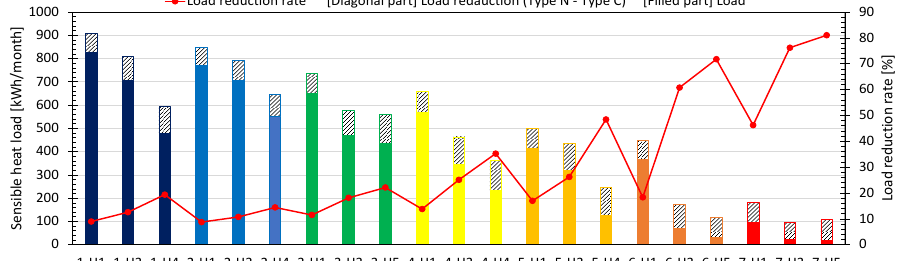
Figure 14. Regional heating load (living room, February).